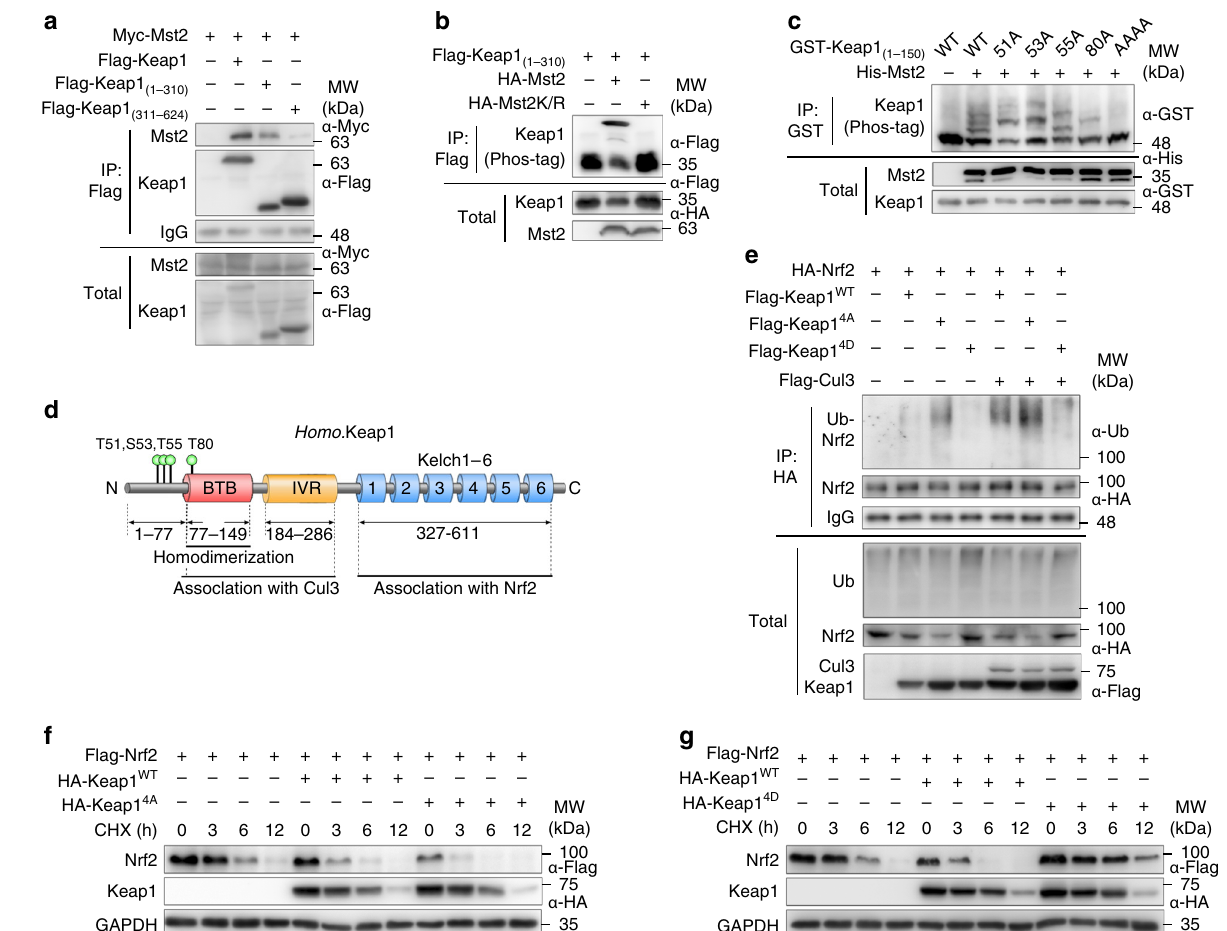
Fig. 6 indenti fi cation of Mst1/2-mediated phosphorylation sites on Keap1. a Immunoblot analysis of Mst2, Keap1 in total lysates (bottom) and anti-Flag IP (top) of 293T cells expressing various combinations (above lanes) of Flag-tagged full length Keap1, truncated Keap1 (1 – 310) or Keap1 (311 – 624) and Myc-tagged Mst2. b Phos-tag and SDS-PAGE analysis of Flag-tagged Keap1 (1 – 310) expressed together with HA-tagged wild-type Mst2 or kinase-inactive Mst2K/R in 293T cells immunoprecipitated with anti-Flag conjugated beads. c Phos-tag and SDS-PAGE analysis of GST-tagged wild-type or various mutated Keap1 (1 – 150) expressed together with His-tagged Mst2 in 293T cells. d Mst1/2 kinases-mediated phosphorylation sites on the Keap1 showing the domains of BTB, IVR, and Kelch1-6; numbers below diagrams indicate amino acid range of each domain. e Immunoassay of the ubiquitination of Nrf2 in anti-HA IP (top) and total lysates (bottom) of 293T cells expressing various combinations (upper lanes) of Flag-tagged Cul3, Flag-tagged WT, mutated Keap1 4A or Keap1 4D , and HA-tagged Nrf2. f , g Immunoblot analysis of total lysates in 293T cells expressing various combinations (above lanes) of HA-tagged wild- type Keap1 WT , mutated Keap1 4A ( f ) or Keap1 4D ( g ) and Flag-tagged Nrf2 followed by CHX treatments with the indicated time. Data are from